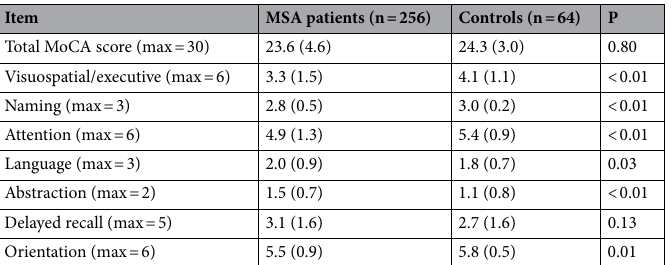
Table 2. MoCA scores of MSA patients and controls. Data are expressed as mean (standard deviation), and “max” indicates the highest score for the item.